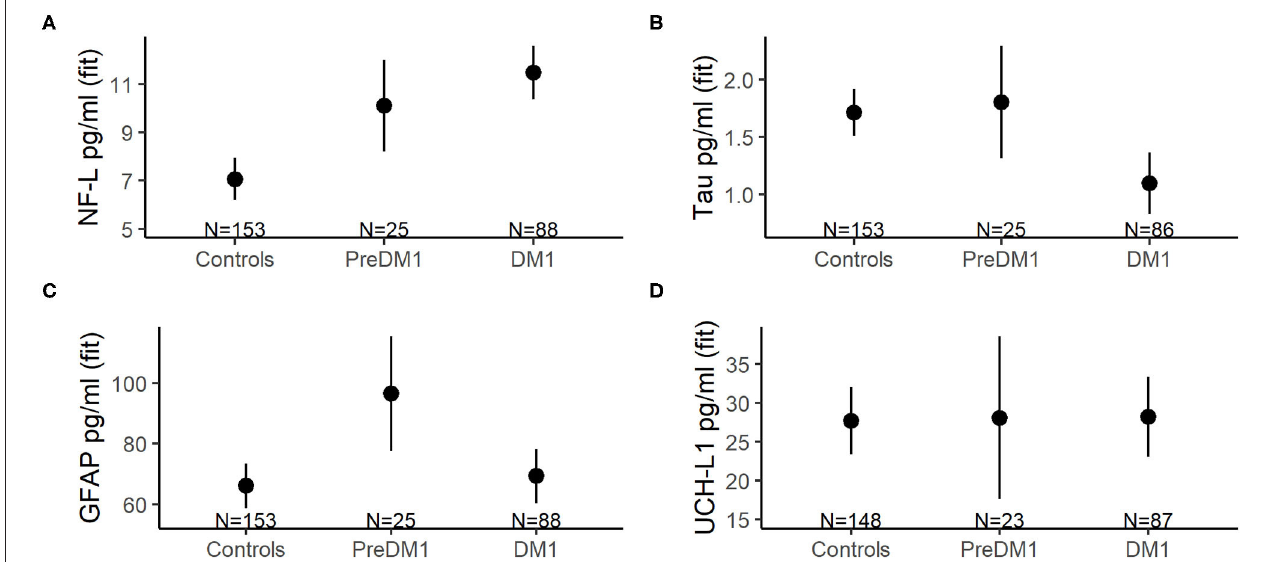
FIGURE 2 | Mean concentrations of NF-L (A) , total tau (B) , GFAP (C) , and UCH-L1 (D) across groups ( x -axes). The group means were derived from mixed linear models that also included main effects for age at evaluation and sex, as well as random intercepts and slopes for age at evaluation, and random effects for participants. The error bars represent 95% confidence limits of the estimated means.